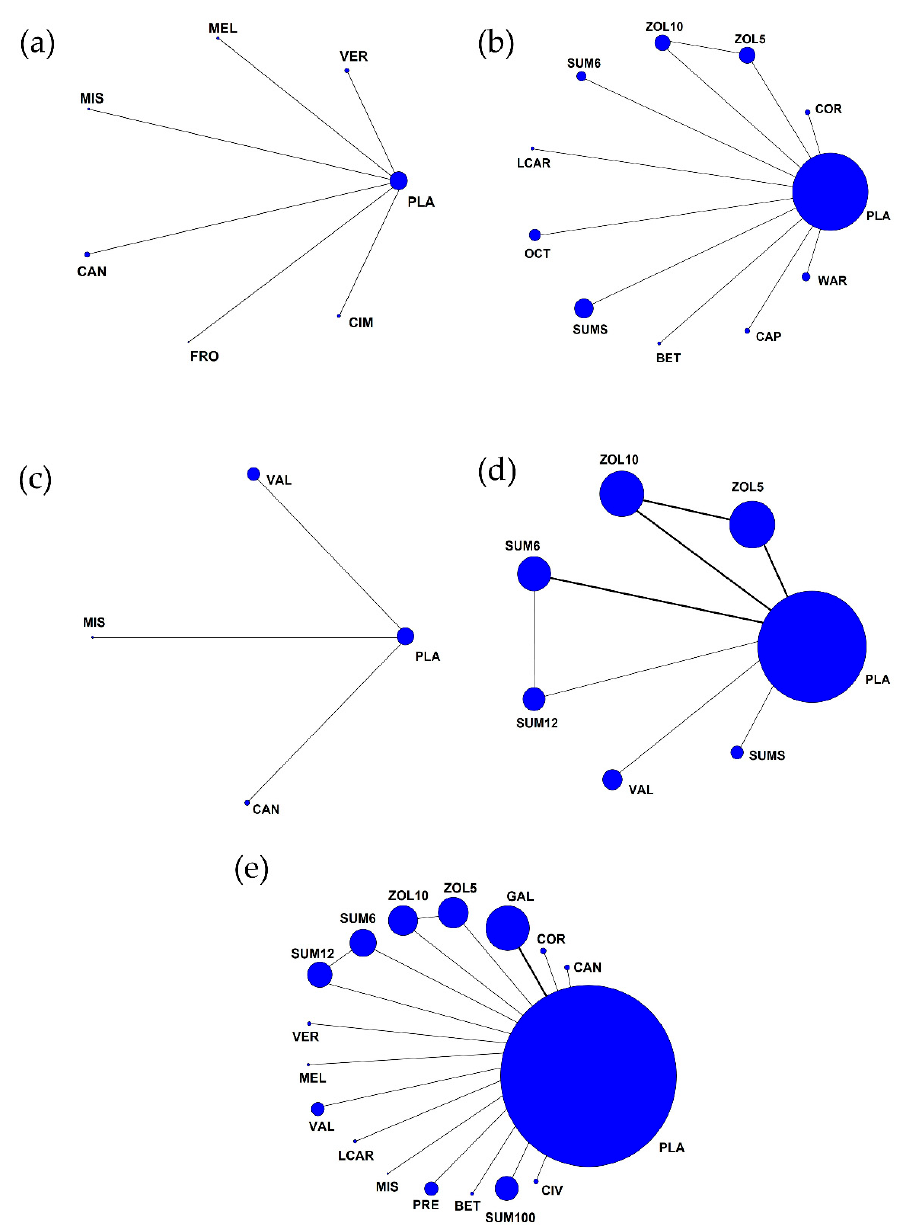
Figure 3. Network comparisons of studies included in the network meta-analysis. ( a ) Frequency of attacks; ( b ) pain-free rate; ( c ) duration of attacks; ( d ) number of patients using rescue agents; ( e ) adverse events. Betamethasone (BET), Candesartan cilexetil (CAN), Capsaicin (CAP), Cimetidine (CIM), Civamide (CIV), Cortivazol (COR), Frovatriptan (FRO), Galcanezumab (GAL), Lithium car- bonate (LCAR), Melatonin (MEL), Misoprostol (MIS), Octreotide (OCT), Placebo (PLA), Prednisone (PRE), Sumatriptan 6 mg (SUM6), Sumatriptan 12 mg (SUM12), Sumatriptan 100 mg (SUM100), Sumatriptan spray (SUMS), Valproate (VAL), Verapamil (VER), Warfarin (WAR), Zolmitriptan 5 mg (ZOL5), Zolmitriptan 10 mg (ZOL10). The size of each circle represents the proportion of the number of patients for each treatment and the width of the lines represents the proportion of the number of studies.